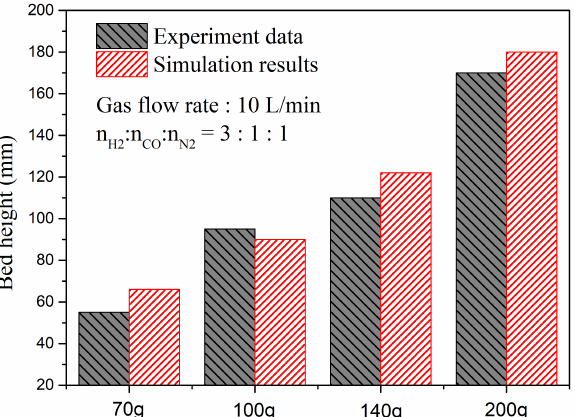
Figure 3. Expanded bed height of the solid phase under different solid